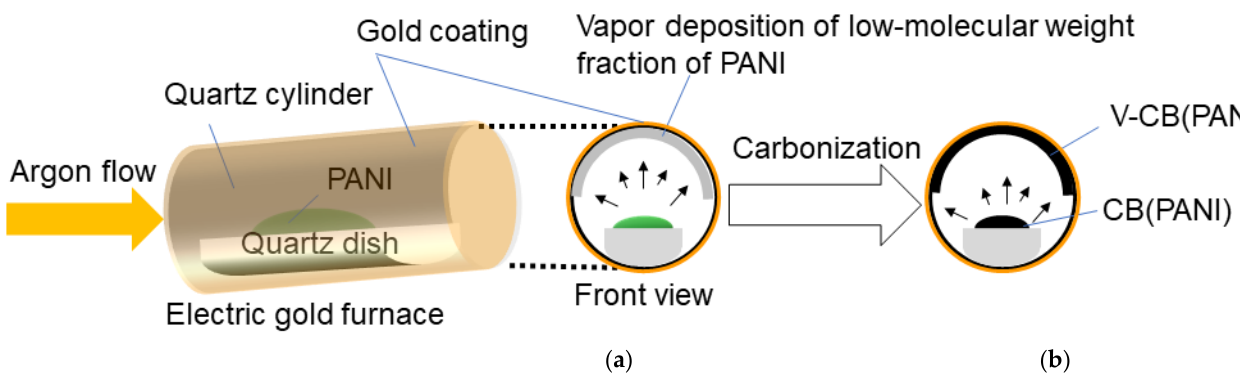
Figure 1. Carbonization procedure of PANI-(+)-CSA in the gold furnace chamber. ( a ) Vapor depo- sition of low-molecular-weight PANI-(+)-CSA on the inside wall of the quartz cylinder in the gold furnace during the heating process; ( b ) Carbonization. V-CB(PANI), vapor-carbonized polyaniline; CB(PANI), carbonized polyaniline.